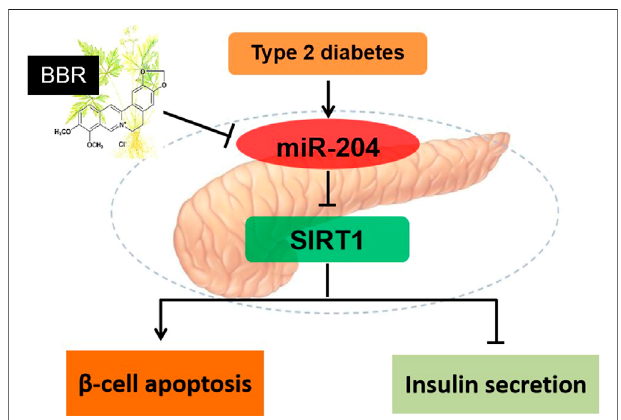
FIGURE 8 | Schematic model of BBR in regulation of β -cell function. miR-204 inhibits SIRT1 to induce apoptosis of islet β -cells and decrease insulin synthesis and secretion, thereby leading to islet β -cell injury in T2DM. BBR alleviates β -cell dysfunction by regulating miR-204/SIRT1